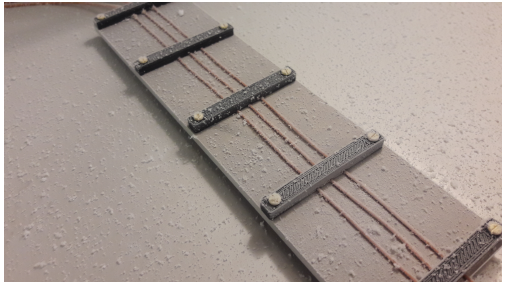
Figure 11. Example of ice layer formed during one of the climate chamber experiments. Here it is possible to see the irregular way ice is formed in a sample with thickness varying from a few µ m to a